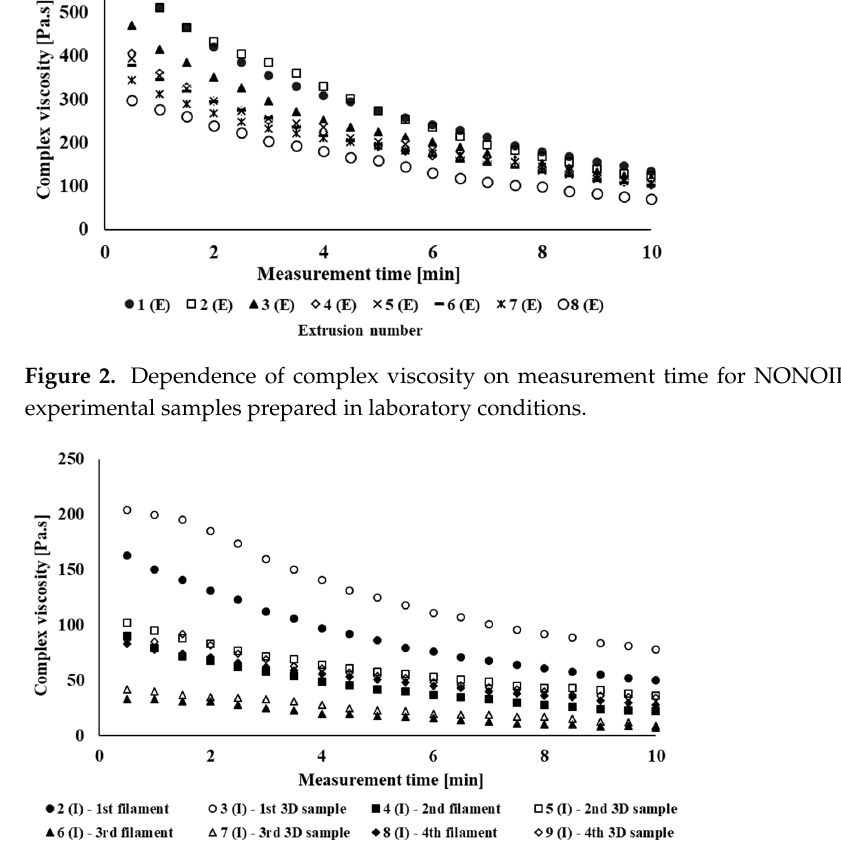
Figure 3. Dependence of complex viscosity on measurement time for commercially processed NONOILEN ® 3D 3056-2 samples.